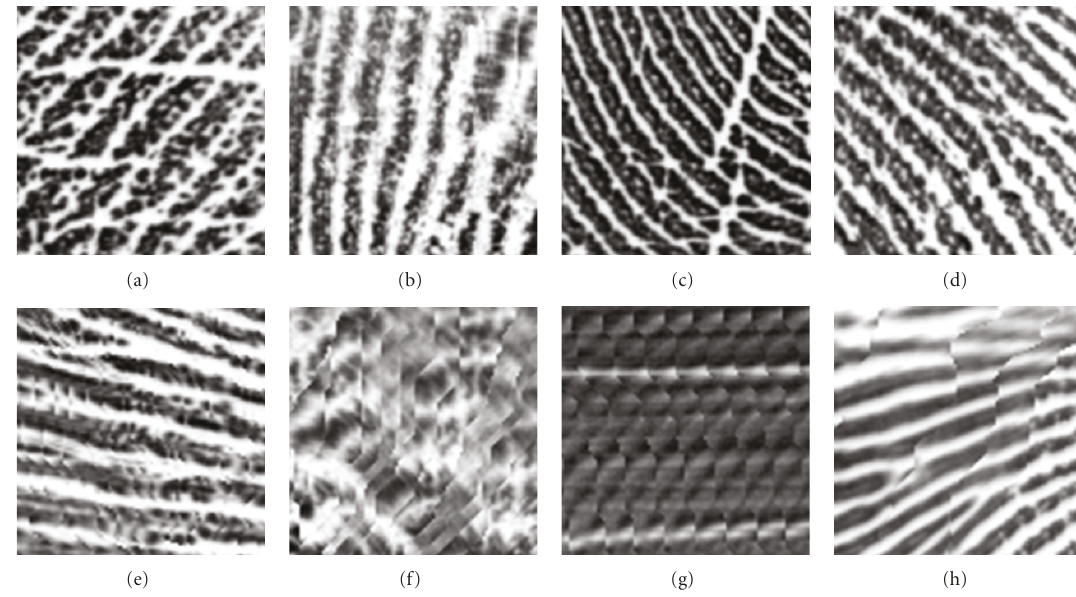
Figure 2: Smear identification challenges. (a)–(d) normal tissues and (e)–(h) defective